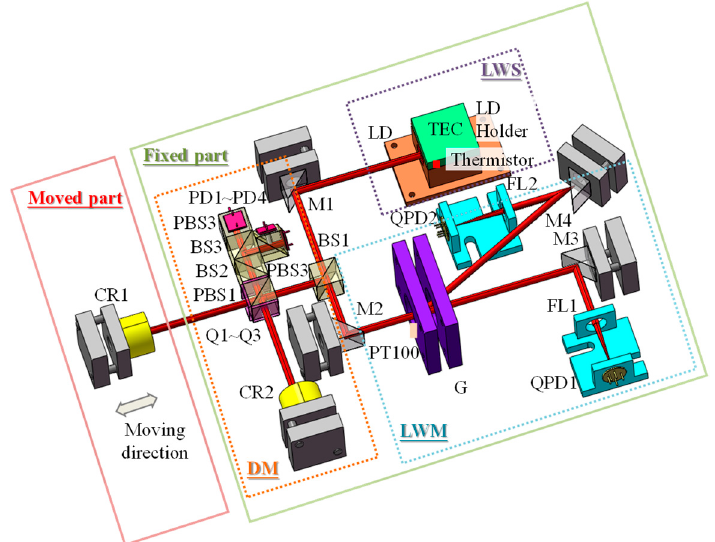
Figure 1. Schematic diagram of the MLDI.